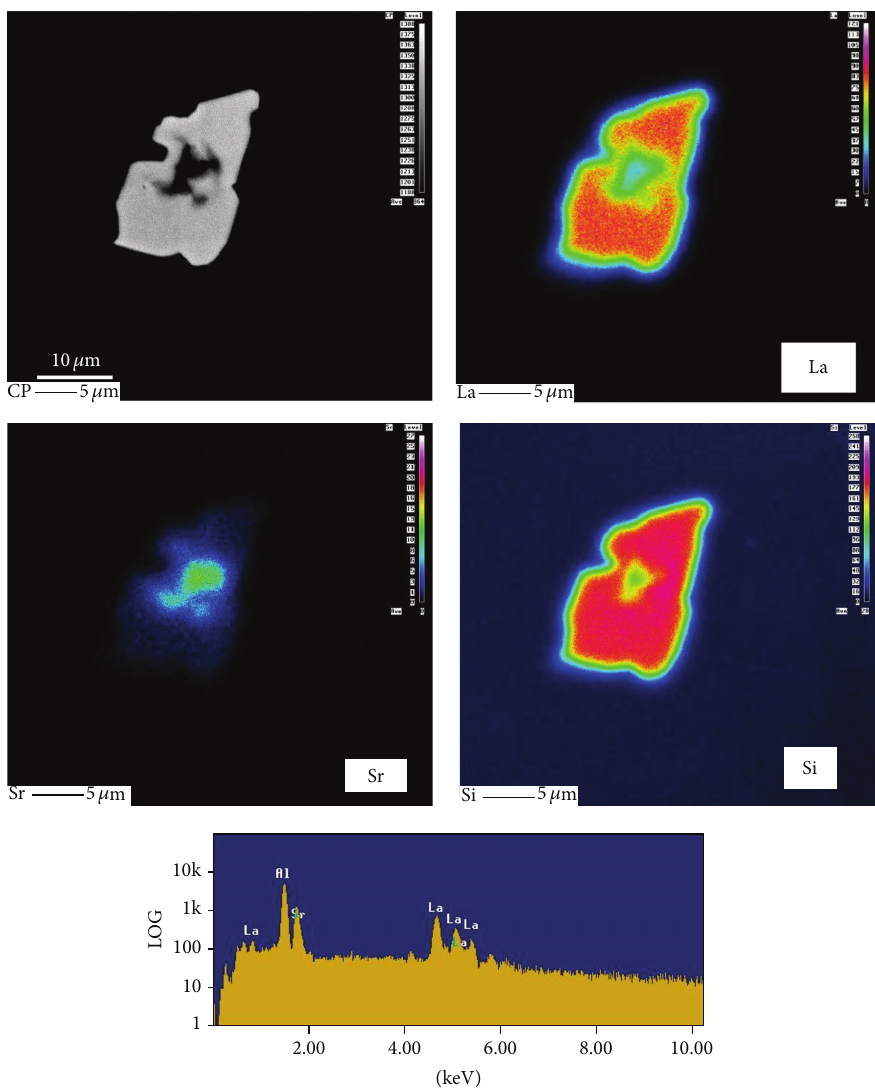
Figure 12: Precipitation of complex intermetallics in T3S